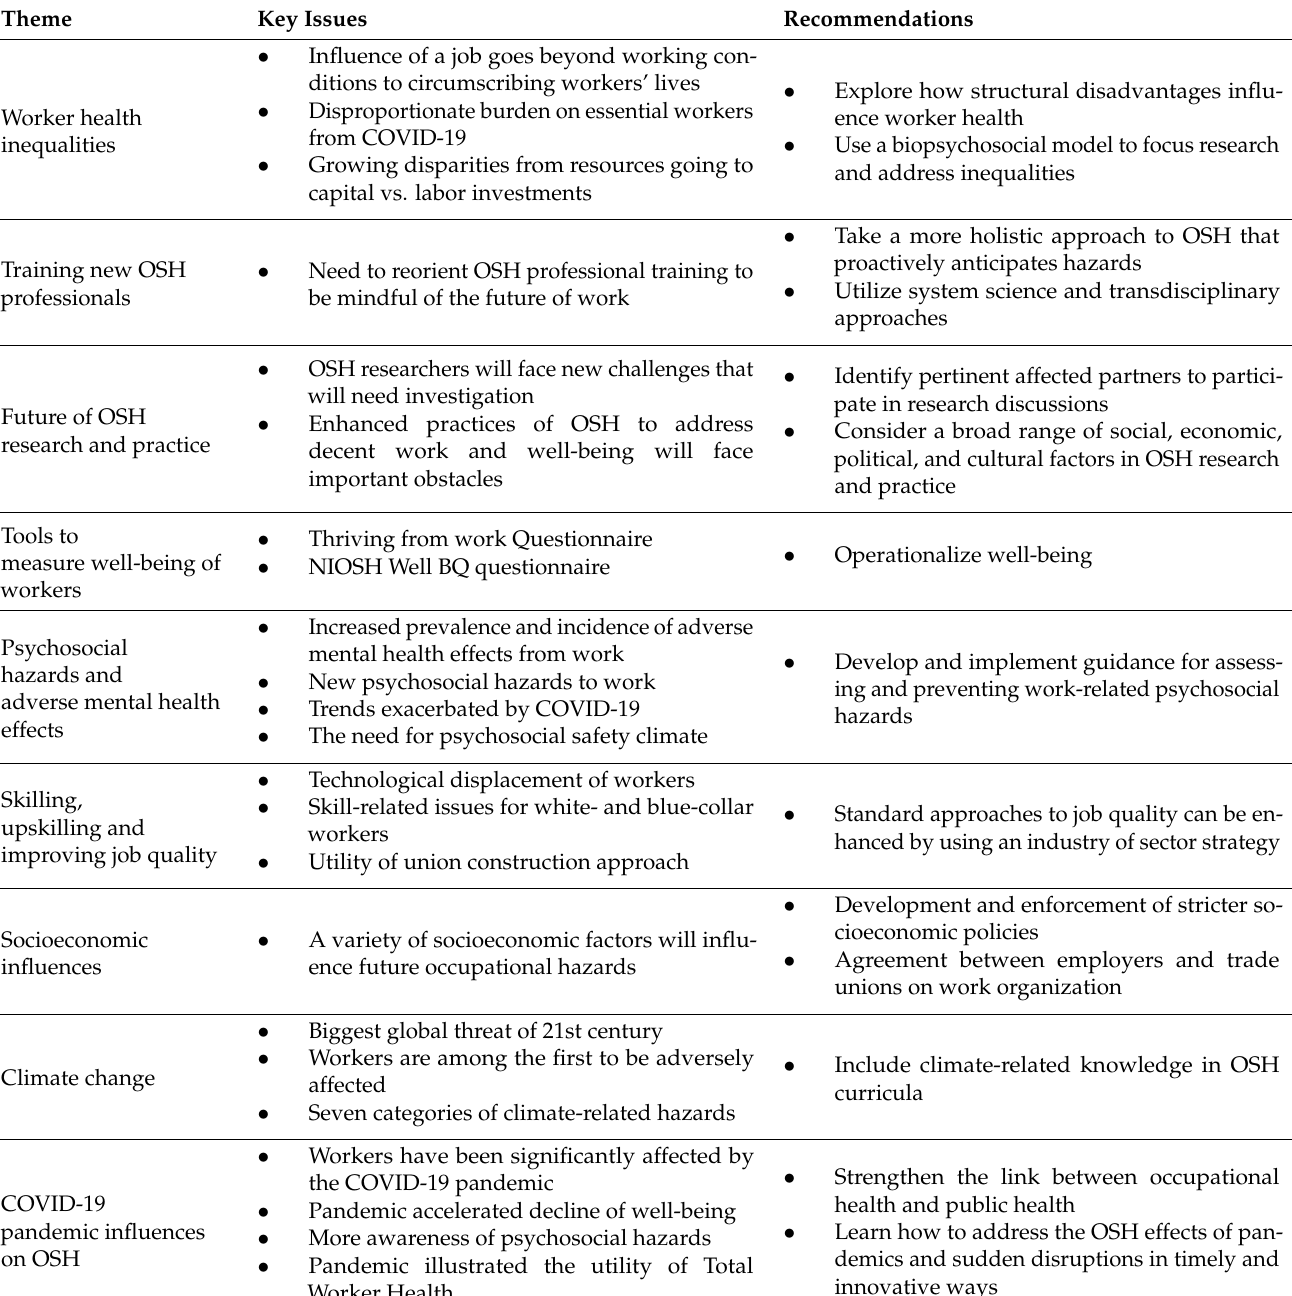
Table 2. Summary of Key Issues and Recommendations for Identified Themes from the Ex4OSH conference 1